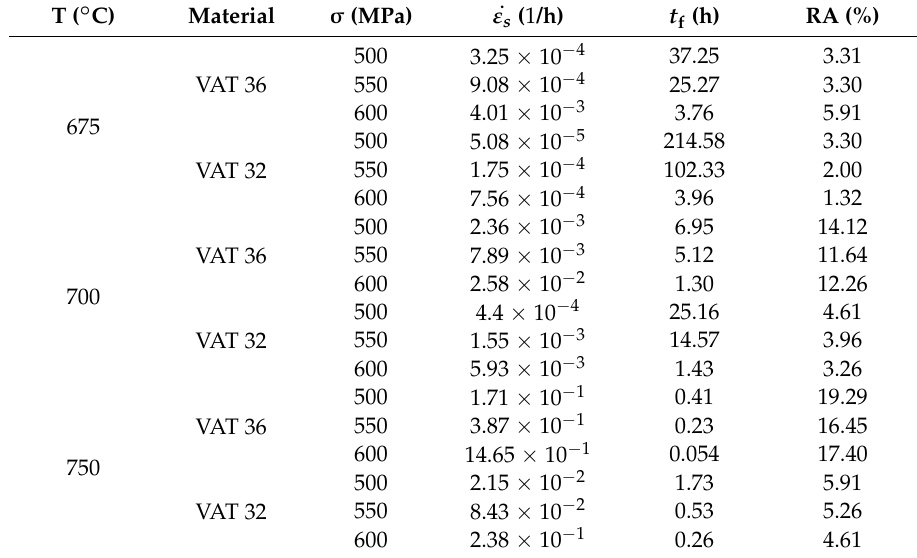
Table 5. Creep tests data of the alloys VAT 36 and VAT 32 at temperatures ( T ) of 675, 700, and 750 ◦ C and stresses ( σ ) of 500, 550, and 600 MPa, showing creep rate ( area